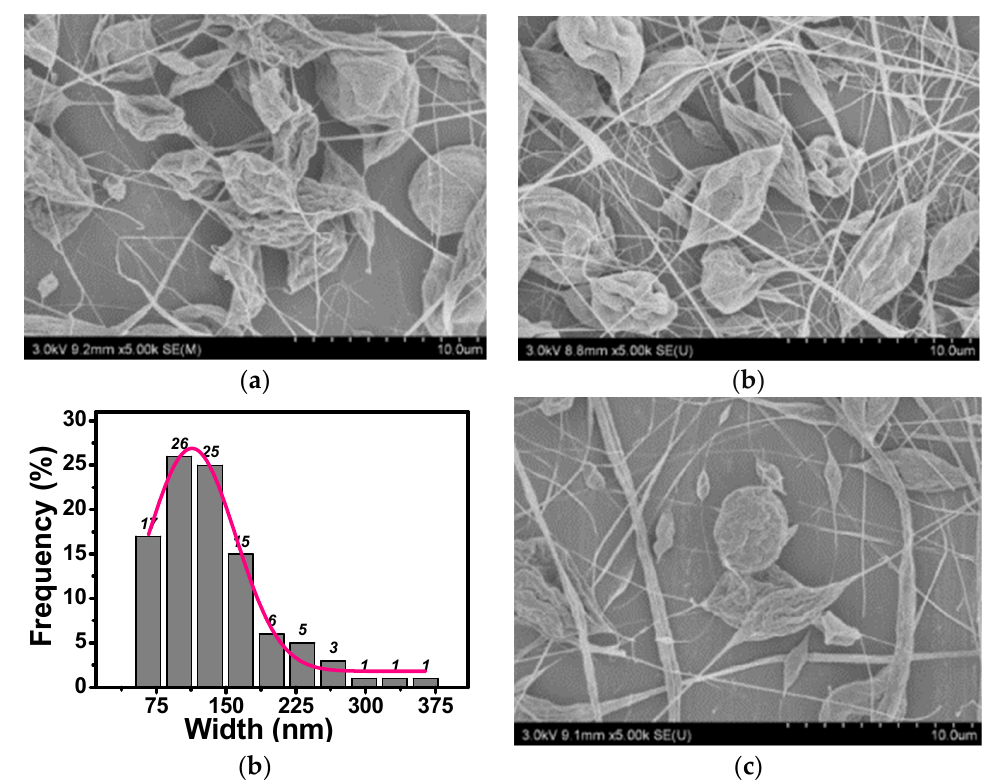
Figure 2. SEM illustrations for cases without additives. ( a ) Sample 1; ( b ) Sample 2; ( c ) Sample 3.